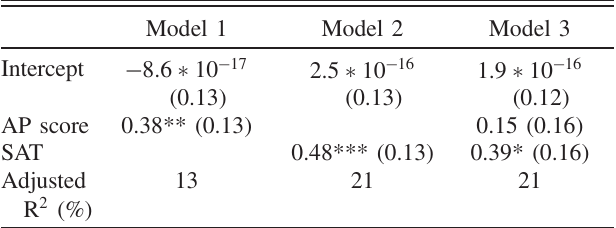
TABLE III. Regression of FMCE prescores on various mea- sures of prior preparation only for students who took the AP test. Each variable is normalized such that the regression coefficients may be interpreted as effect sizes (Cohen ’ s d ). The standard error for each coefficient is given in parentheses. (cid:2) (cid:2) (cid:2) p < 0 . 001 , (cid:2) (cid:2) p < 0 . 01 , (cid:2) p < 0 . 05 .